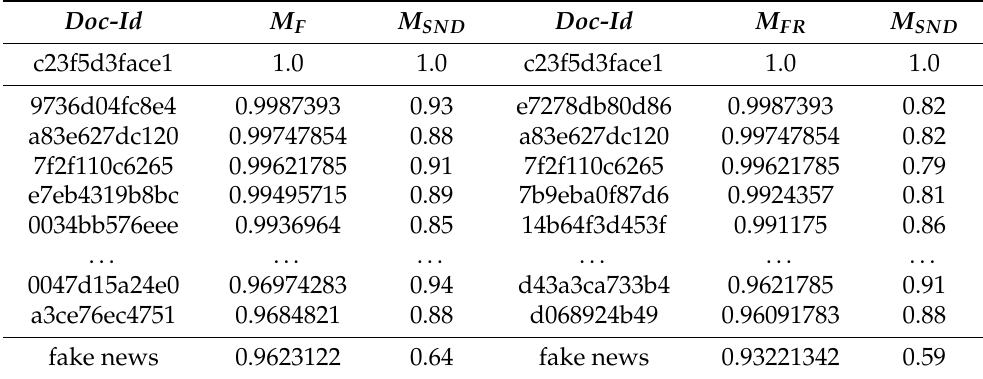
Table 1. Soundness calculation based on the Washington Post